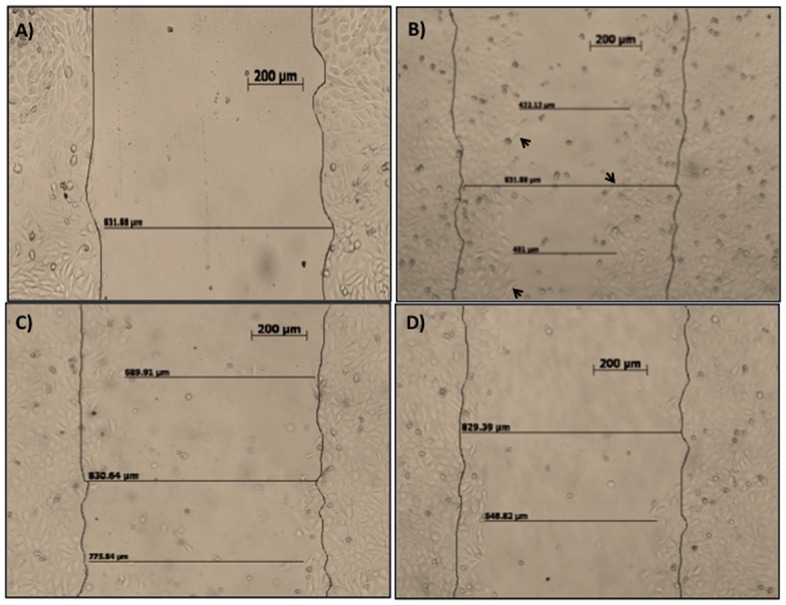
Keratinocyte-conditioned medium mediate keratinocyte migration (in vitro wound closure assay).HaCaT cells were grown to confluence on 24-well tissue culture plates. Then each well was denuded by half from cells and re-coated with fibronectin. The cells were incubated with KCM from DFUs, 0 h. (6A); KCM, 48 h. (6B); KCM with goat polyclonal anti-HBD-2, 48 h (6C); KCM with goat polyclonal anti-LL-37 (6D). Migrations were photographed and monitored for up to 48 h. Data shown are representative of three independent experiments. Bar = 200 µm.